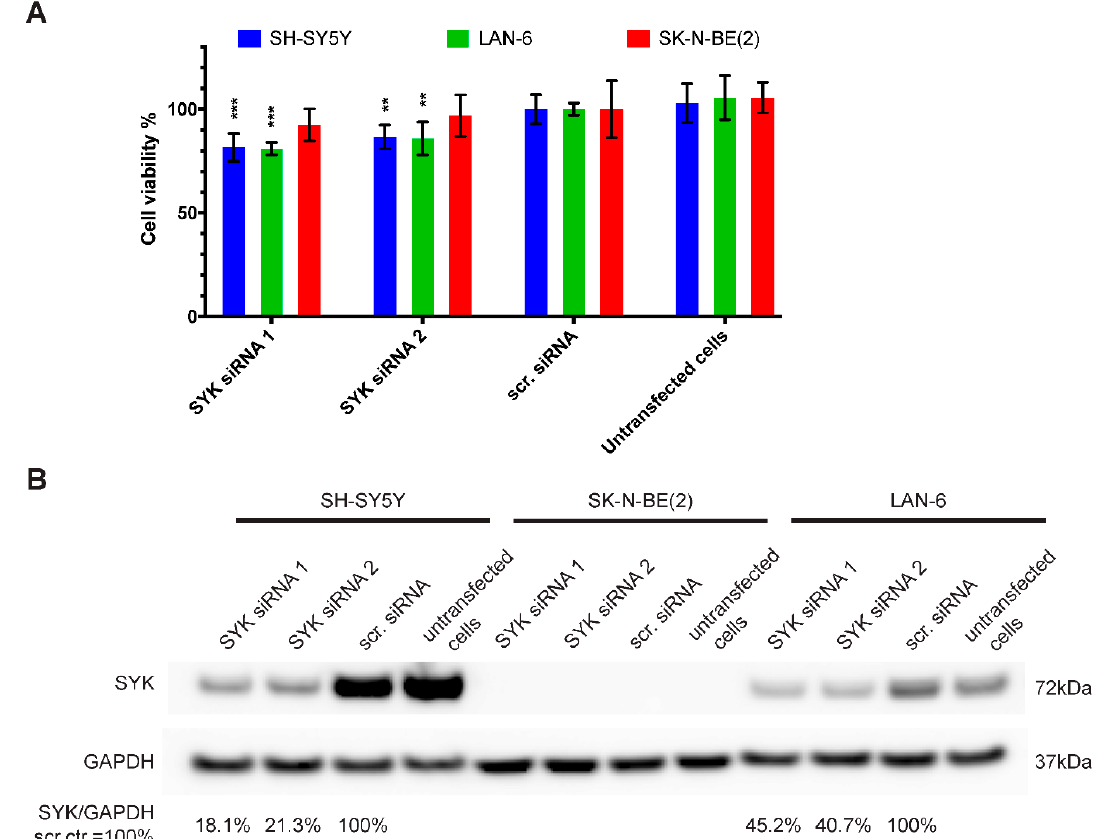
Figure 4. SYK downregulation reduces the cell viability of SYK expressing neuroblastoma cell lines. SYK-positive SH-SY5Y and LAN-6 cells, as well as SYK-negative SK-N-BE(2) cells, were transfected with 5 pmol SYK specific or scrambled (scr.) siRNA. The medium was replaced after 4 h. After 72 h, the cell viability was evaluated by MTT assay ( A ). The scr. control was set as 100% viable cells. Data are presented as mean ± SD from three independent experiments. Statistical comparisons were made using two-way ANOVA and a significant effect was observed for the siRNA treatment p < 0.001 and between cell lines p = 0.003. The Dunnett’s multiple comparison test was used to evaluate the difference between scr. siRNA vs. SYK specific siRNA: ** p < 0.01, *** p < 0.001. ( B ) SYK expression levels were determined by western blot.